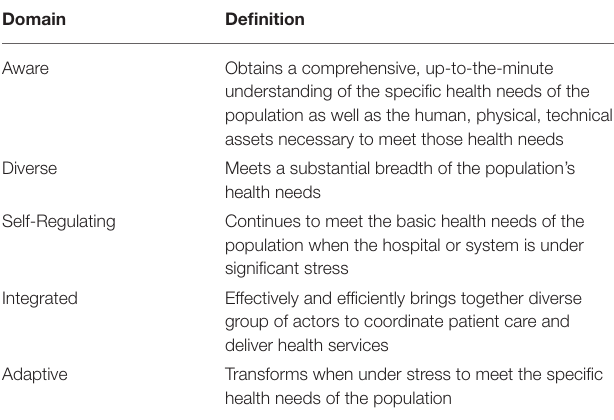
TABLE 3 | Health System Resilience